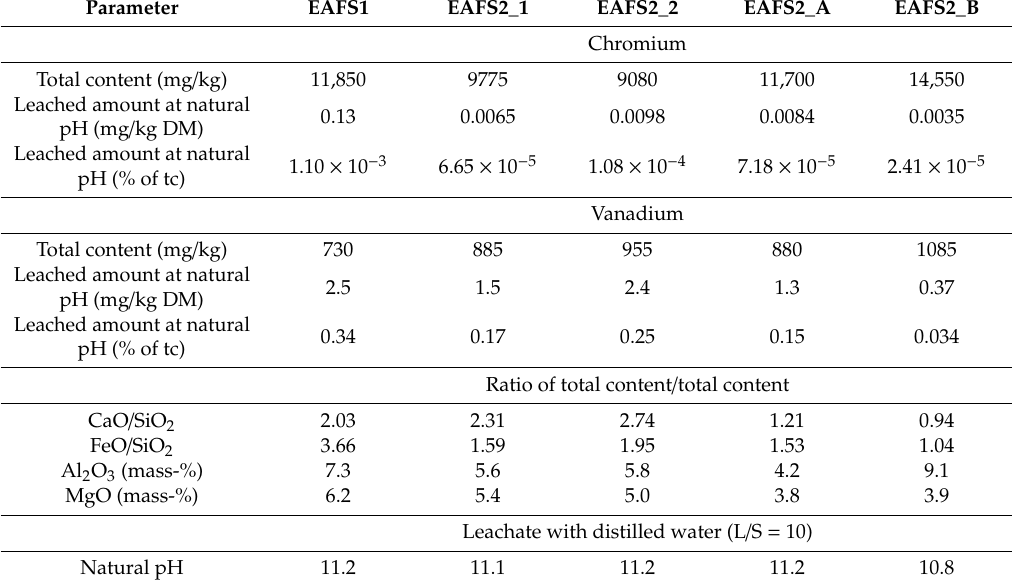
Table 4. Total content (tc) and leached amount at natural pH (in mg / kg DM and % of tc) for Cr and V as well as basicity (CaO / SiO 2 ), FeO / SiO 2 ratio, Al 2 O 3 , and MgO